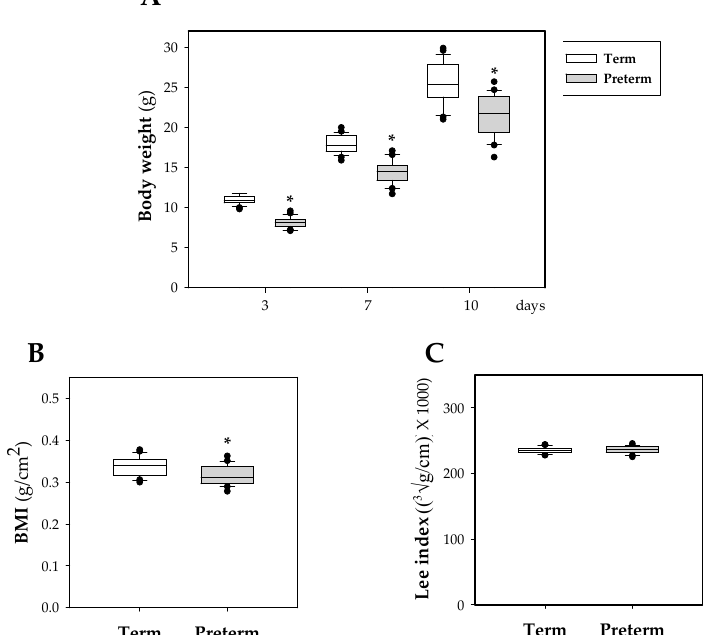
Figure 1. Box plot of the influence of prematurity on body weight and morphometric variables. Rat body weight along the study ( A ), BMI ( B ) and Lee index ( C ) at day 10 of life in both experimental groups. Line indicates the median, box shows the interquartile range (IQR) and the whiskers are 1.5 × IQR ( n = 20 pups per group). Statistical differences: * p < 0.05 vs. term group.